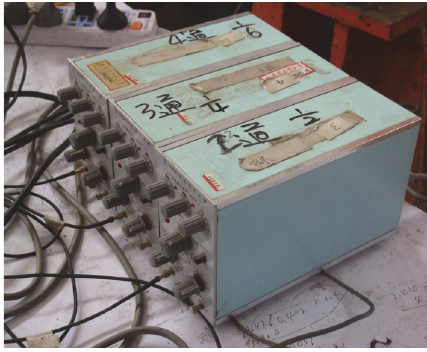
Figure 9: Acceleration